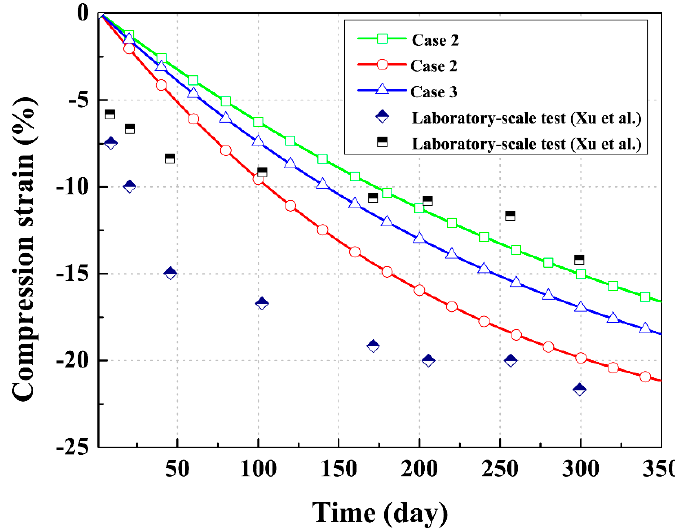
Figure 10. Stabilization process of settlement in landfill.